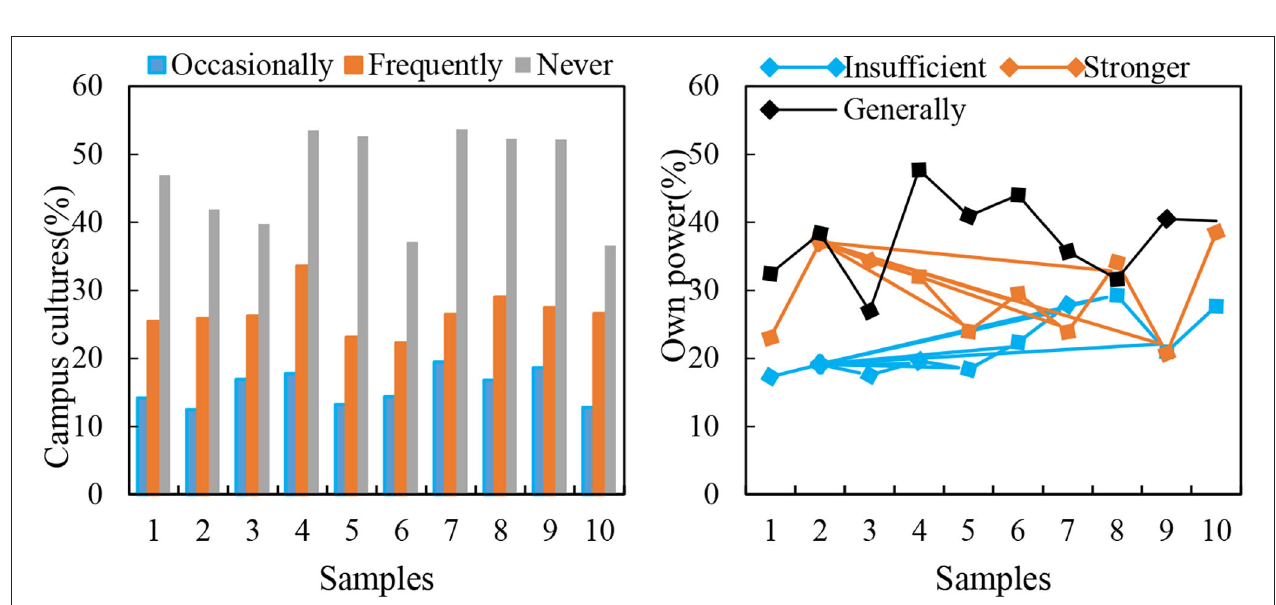
FIGURE 7 | The relationship between happiness and money guided by positive psychology.